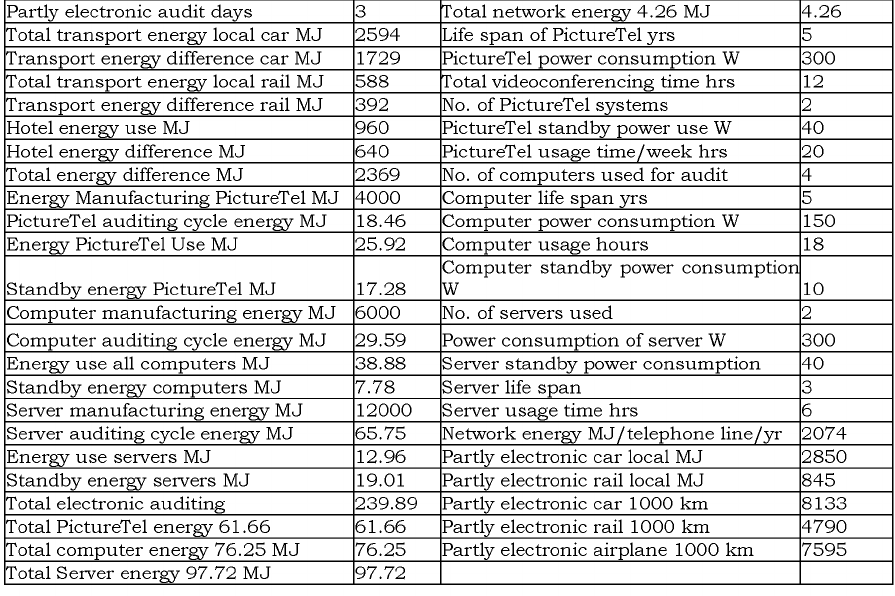
In both cases, that is, traditional auditing and partly electronic auditing, the major contributor of energy consumption was transportation followed by hotel accommodation. Railway